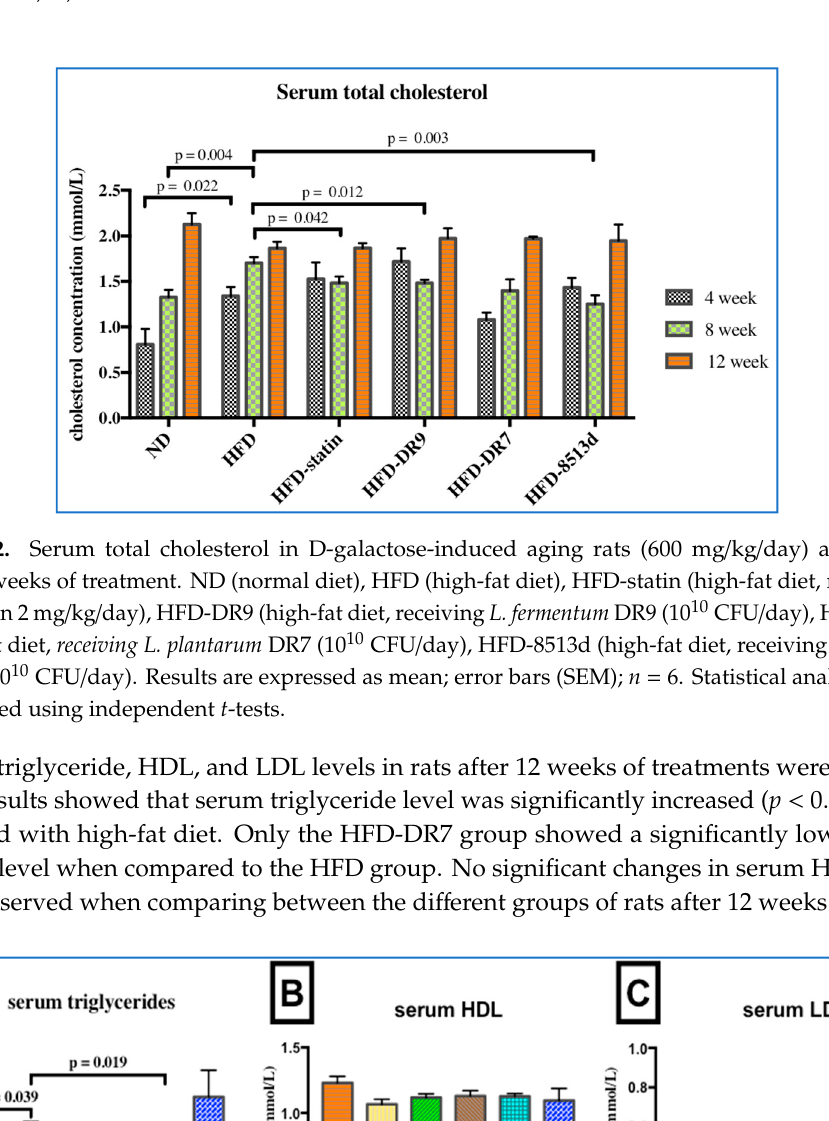
Figure 3. Serum triglyceride ( A ), HDL ( B ), and LDL ( C ) in D-galactose-induced aging rats (600 mg/kg/day) after 12 weeks of treatment. ND (normal diet), HFD (high-fat diet), HFD-statin (high-fat diet, receiving lovastatin 2 mg/kg/day), HFD-DR9 (high-fat diet, receiving L. fermentum DR9 (10 10 CFU/day), HFD-DR7 (high-fat diet, receiving L. plantarum DR7 (10 10 CFU/day), HFD-8513d (high-fat diet, receiving L. reuteri 8513d (10 10 CFU/day). Results are expressed as mean; error bars (SEM); n = 6. Statistical analysis was performed using independent t -tests.